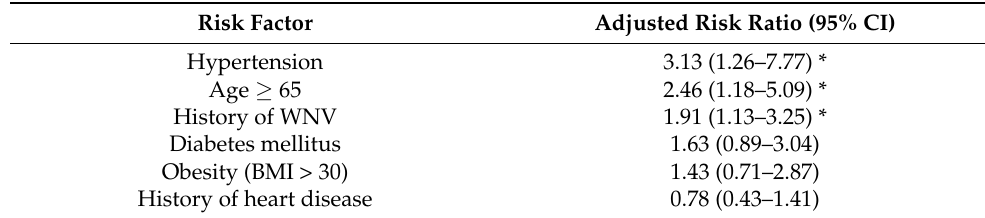
Table 2. Log binomial regression analysis adjusted for meaningful CKD risk factors among both WNV-positive cases and WNV-negative